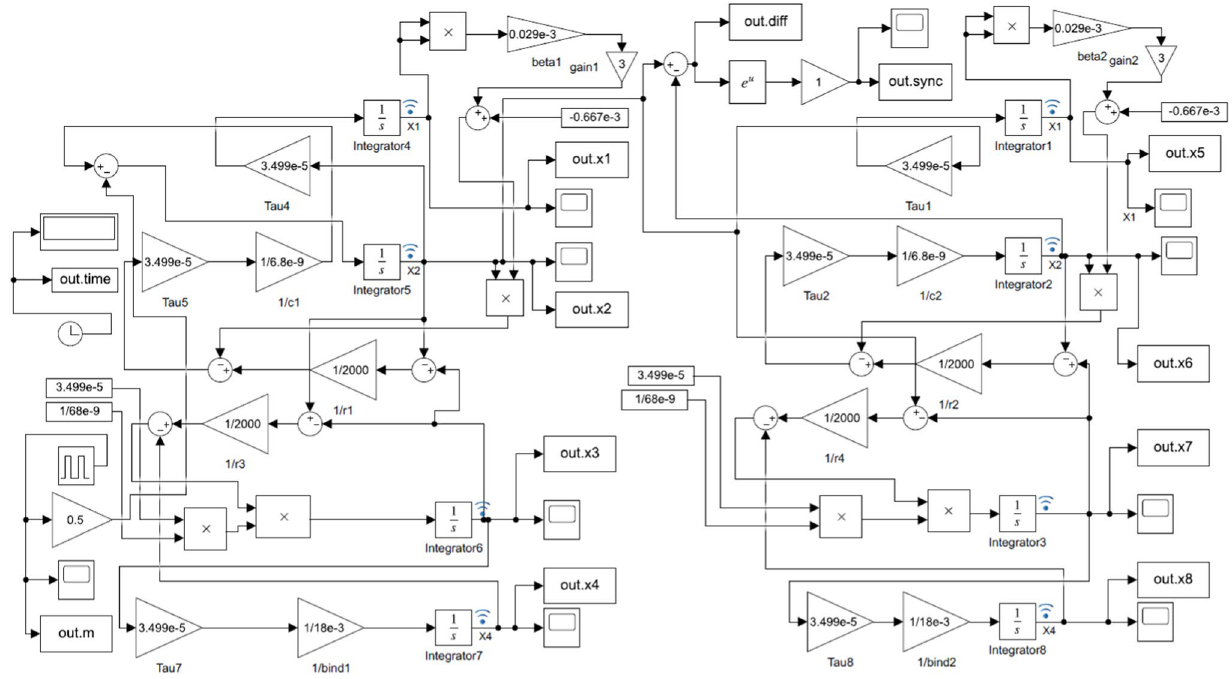
Fig. 8 Simulation of memristor-based Chua’s chaotic circuit in MATLAB